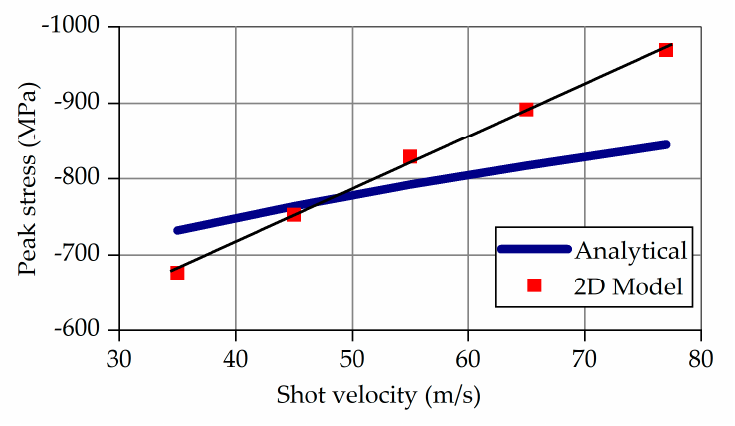
Figure 8. Analytical and numerical (2D model) values of the maximum compressive residual stress. The red marks in Figure 8 correspond to the 2D model’s results for the various veloci- ties at vertical impact. Linear regression of the red marks yields the thin black line. The thick blue line represents the analytical results according to Equation (5). The deviations are acceptable, amounting from 9 to 13% for the lowest and the highest velocity, respectively.